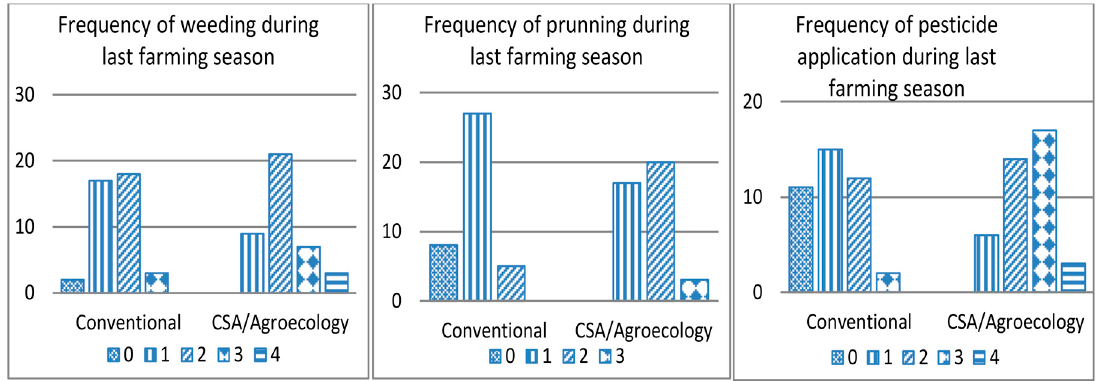
Figure 4. Frequency of selected farm management practices per farming systems. Source: Field Data (2015).